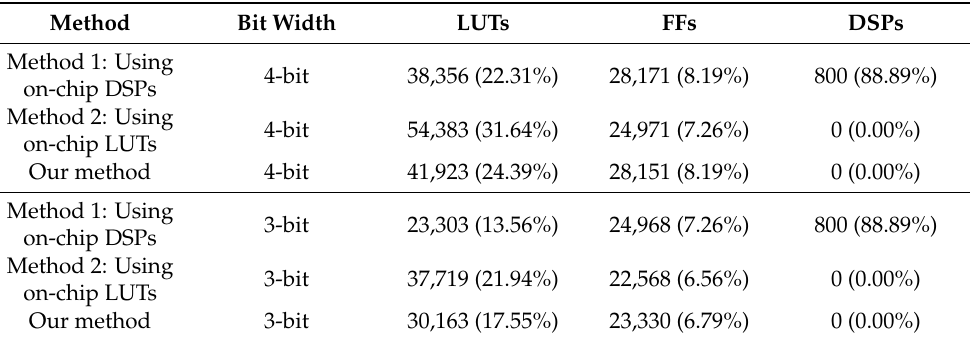
Table 12. On-chip resource occupation for convolutional computation at 32-channel